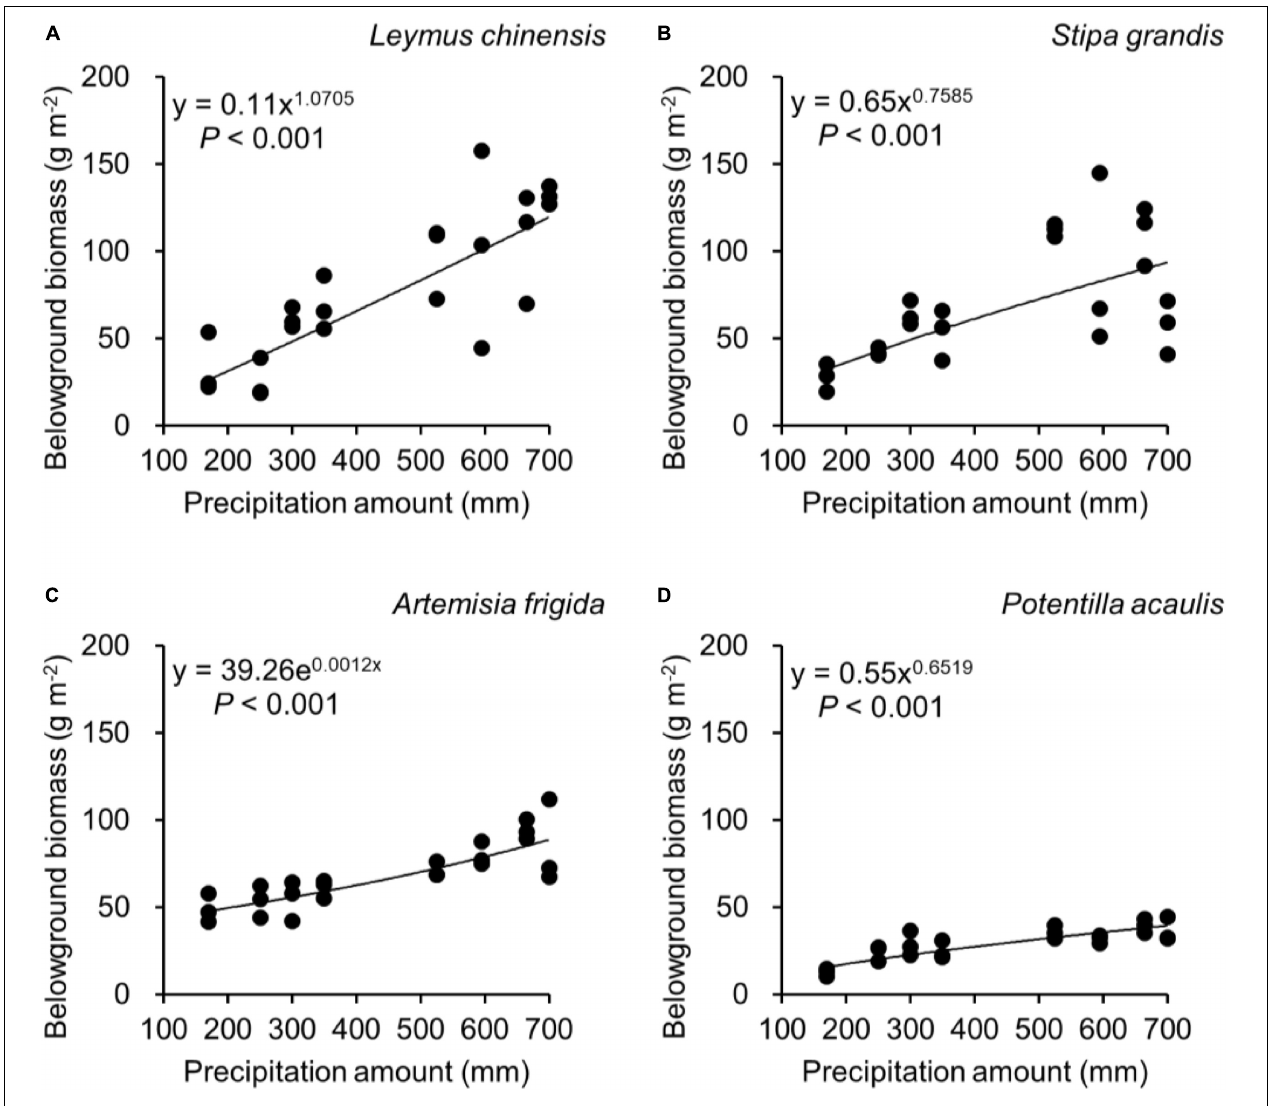
FIGURE 3 | At the pot scale, regressions between precipitation amount and belowground biomass, separately for (A) Leymus chinensis , (B) Stipa grandis , (C) Artemisia frigida , and (D) Potentilla acaulis.